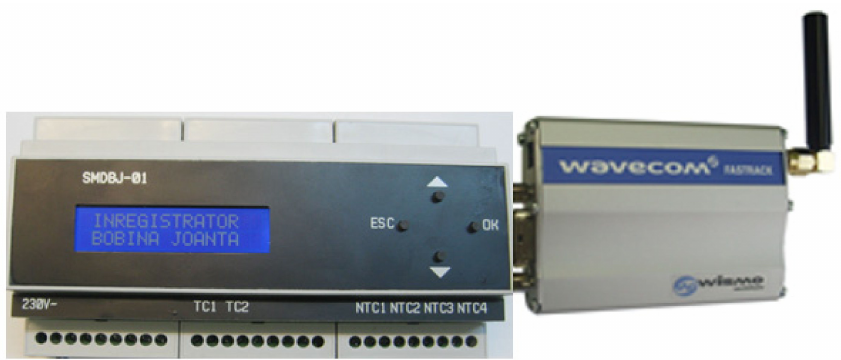
Figure 7. Monitoring device of return circuit using GSM